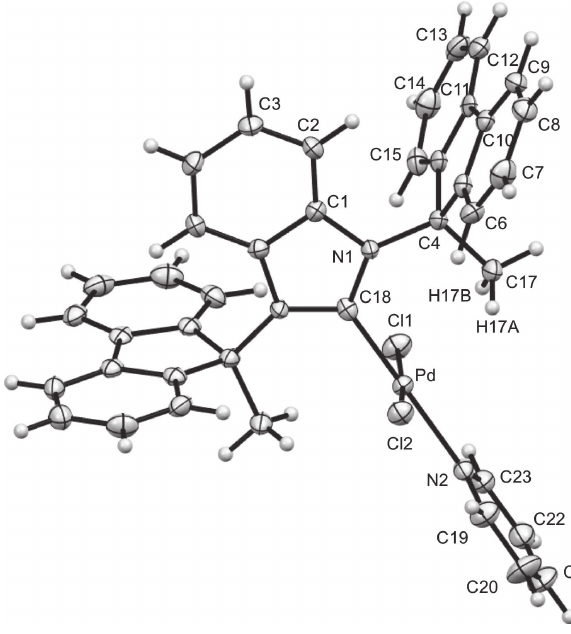
Table 1: Data collection and handling. Crystal: